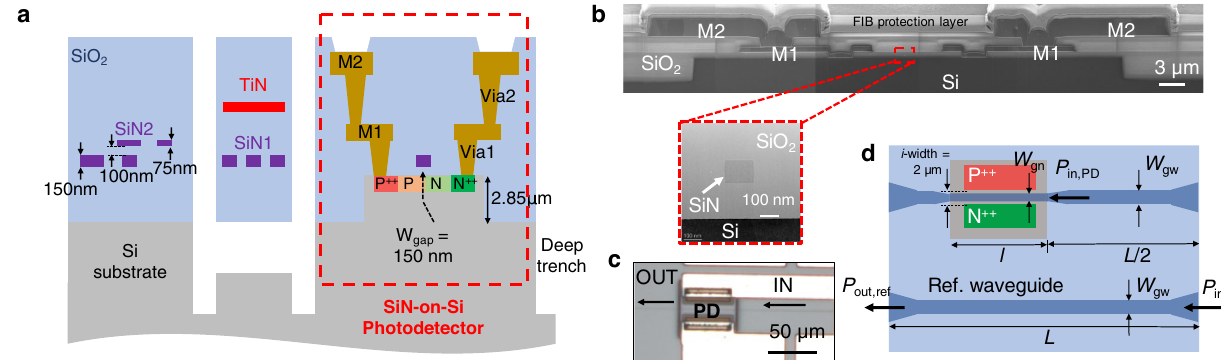
Fig. 1 | SiN-on-Si waveguide photodetectors (PDs). a Cross-section of the visible spectrum integrated photonic platform on 200-mm Si. The platform consists of two SiN waveguide layers (SiN1 and SiN2), a Si undercut, two metal layers (M1 and M2)connected by viasVia1and Via2, titanium nitride (TiN) high resistivity heaters, P ++ ,P,N,andN ++ dopedregionsonaSimesaforphotodetection,andadeeptrench for waveguide facets. The nominal dimensions are indicated. The cross-section of the PD, which has a PN (in a )) or PIN junction (intrinsic region width = 2 μ m, a top view shown in d ), is demarcated by the red dashed box. W gap is the separation